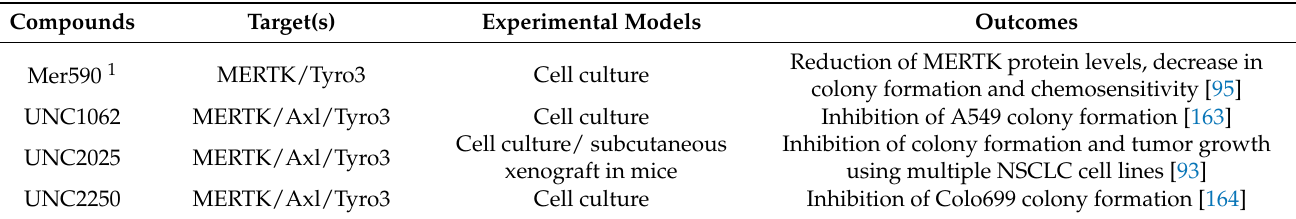
Table 1. MERTK inhibitors in preclinical development for